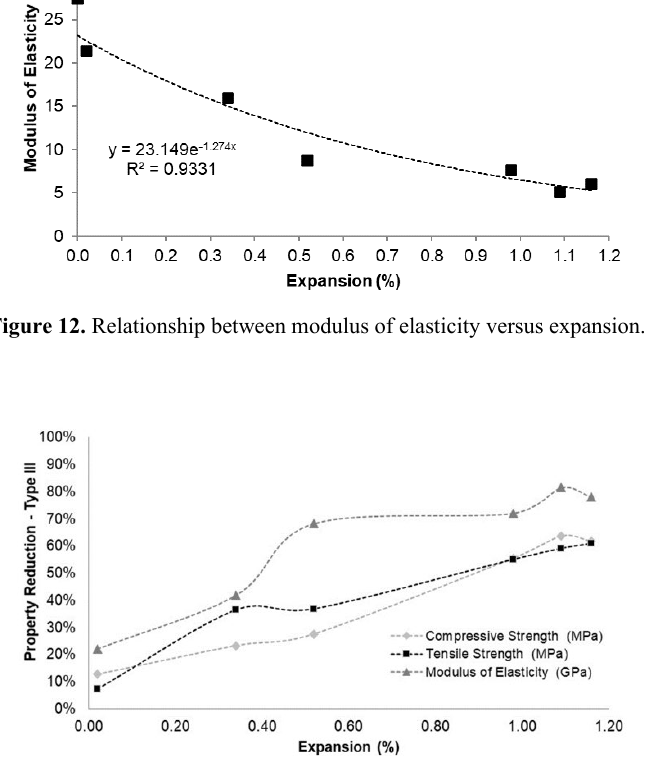
Figure 13. Correlation between the mechanical properties and expansion for Type III cement.